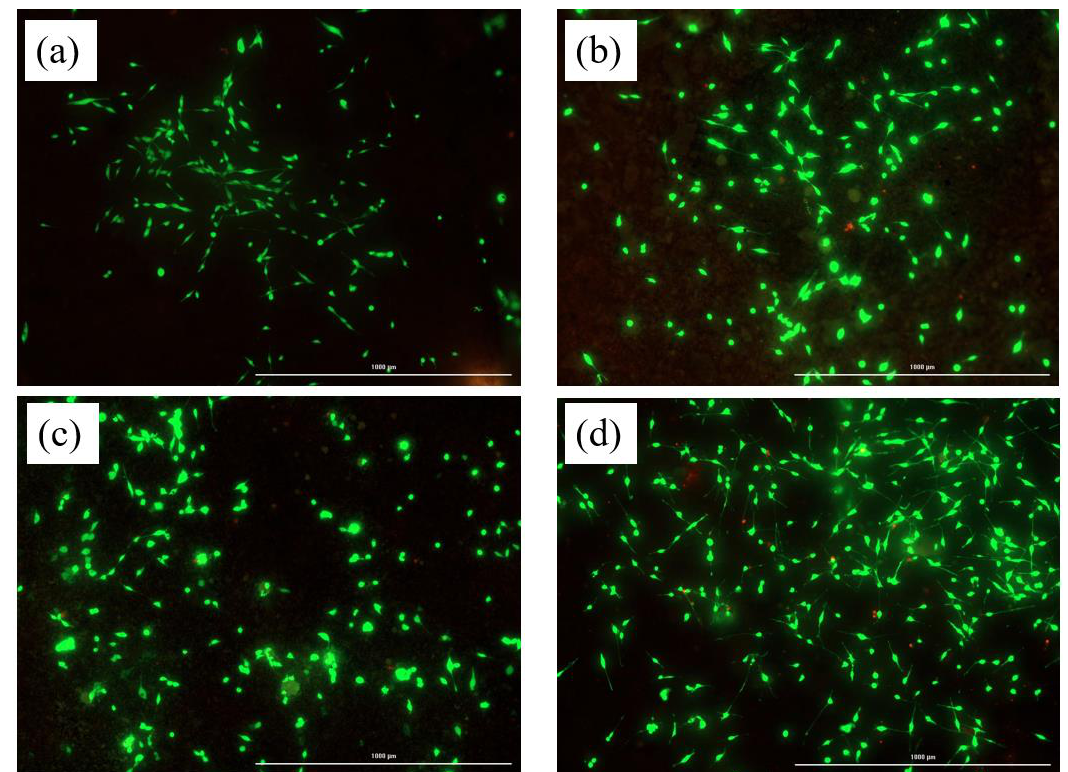
Figure 10. Live and dead cell assay for the cells attached and proliferating along the surface of ( a ) CPC-0 BT, ( b ) CPC-20 BT, ( c ) CPC-40 BT, and ( d ) HA surface at day 5. The viable cells are indicated by green fluorescence and dead cells by red fluorescence. Scale 1000 µm.